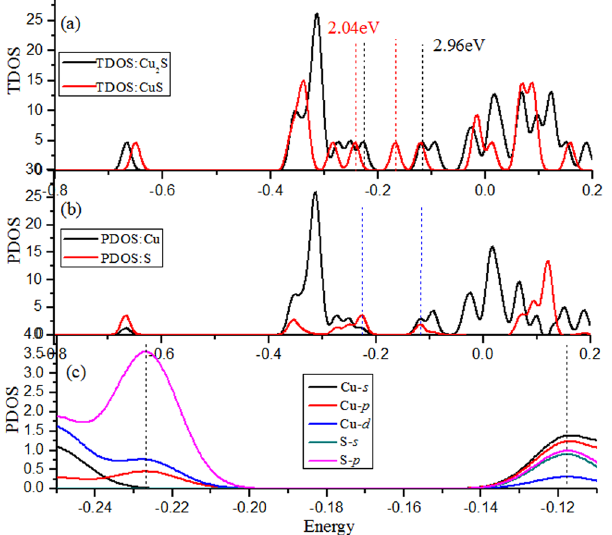
Figure 4. ( a ) Total densities of states for CuS and Cu 2 S clusters. ( b ) Partial densities of states of Cu 2 S clusters. ( c ) Partial densities of states for copper atom in Cu 2 S clusters. (full width at half maximum (FWHM) = 0.02 a.u.) The dashed line indicates the HOMO and LUMO